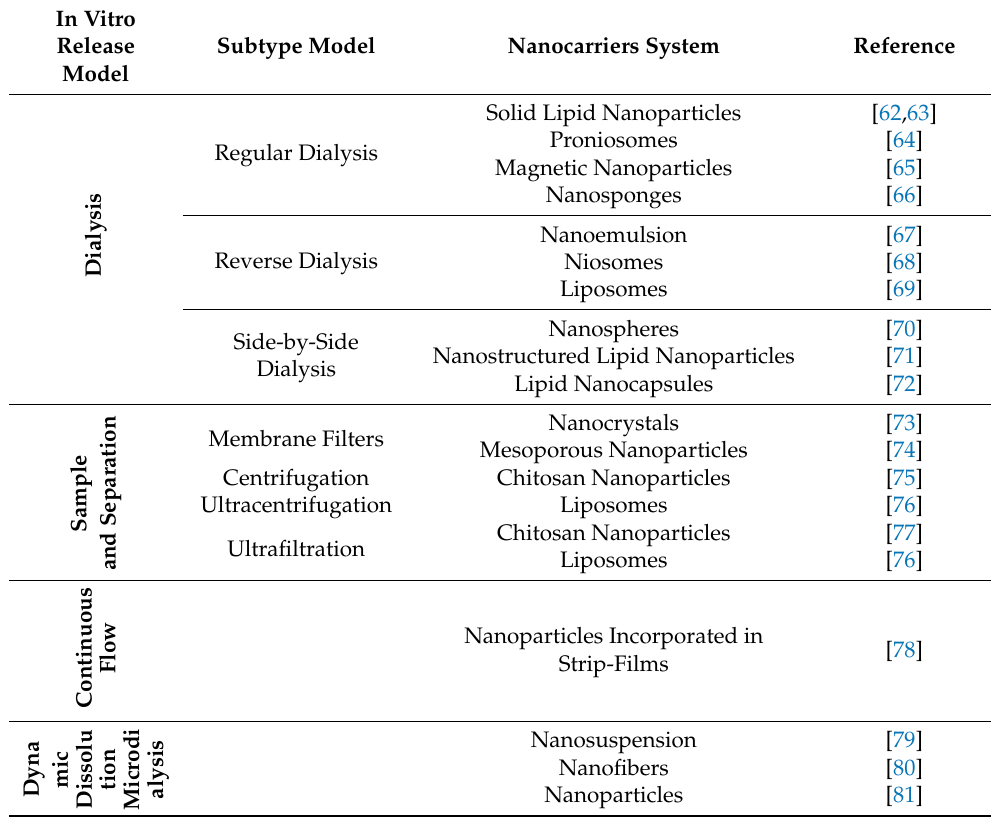
Table 1. In vitro drug release assessment techniques adopted for variable